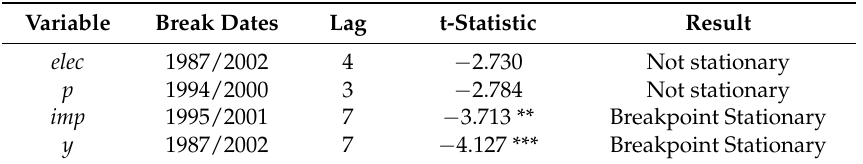
Table 2. LM two breaks unit root test (Lee-Strazicich test [53]).